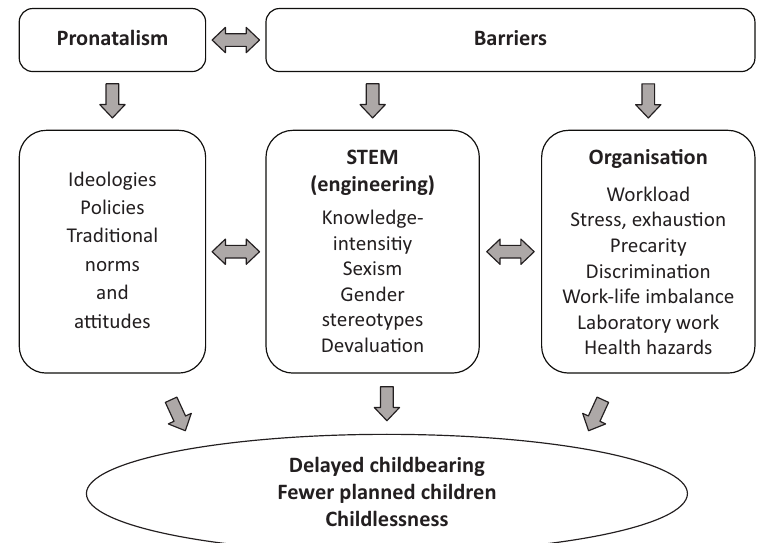
Figure 1. Changing motherhood‐related plans of female PhD students in the STEM